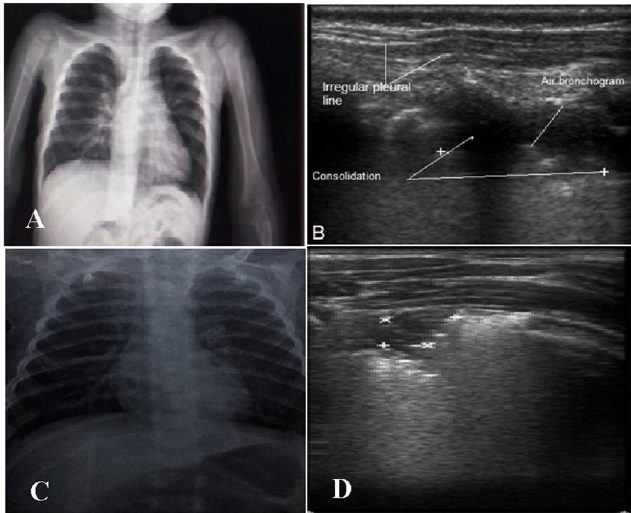
Figure 3. ( A , B ) Two-year-old male with bacterial bronchopneumonia. ( A ): CXR showing no consolidation.